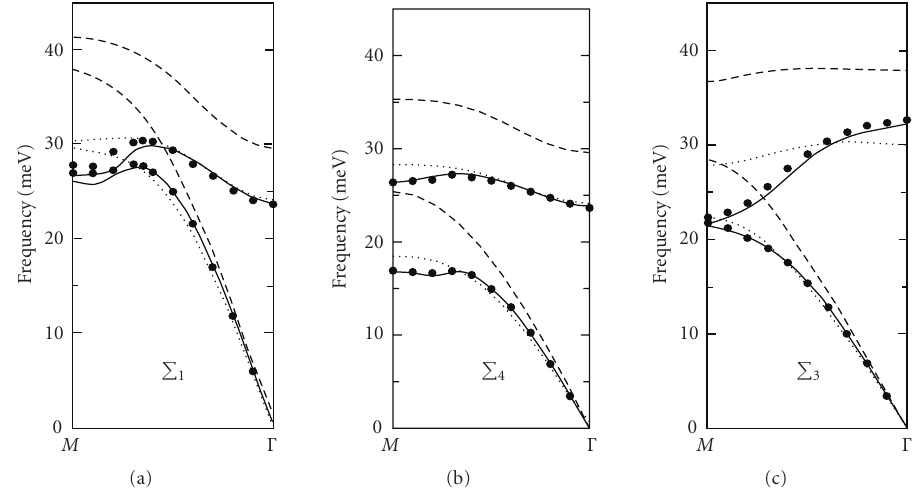
Figure 3: Phonon dispersions in Ru (from [8]). The data points correspond to experimental results. The solid lines represent results of the full DFT/LDA calculation. The Dotted lines were obtained by replacing q -dependent electron-phonon matrix element with the average value (which was q -independent). The dashed lines represent the DFT calculation without including the conduction electrons. Disappearance of the phonon softening near the M-point upon exclusion of conduction electrons demonstrates that the dip results from electron-phonon